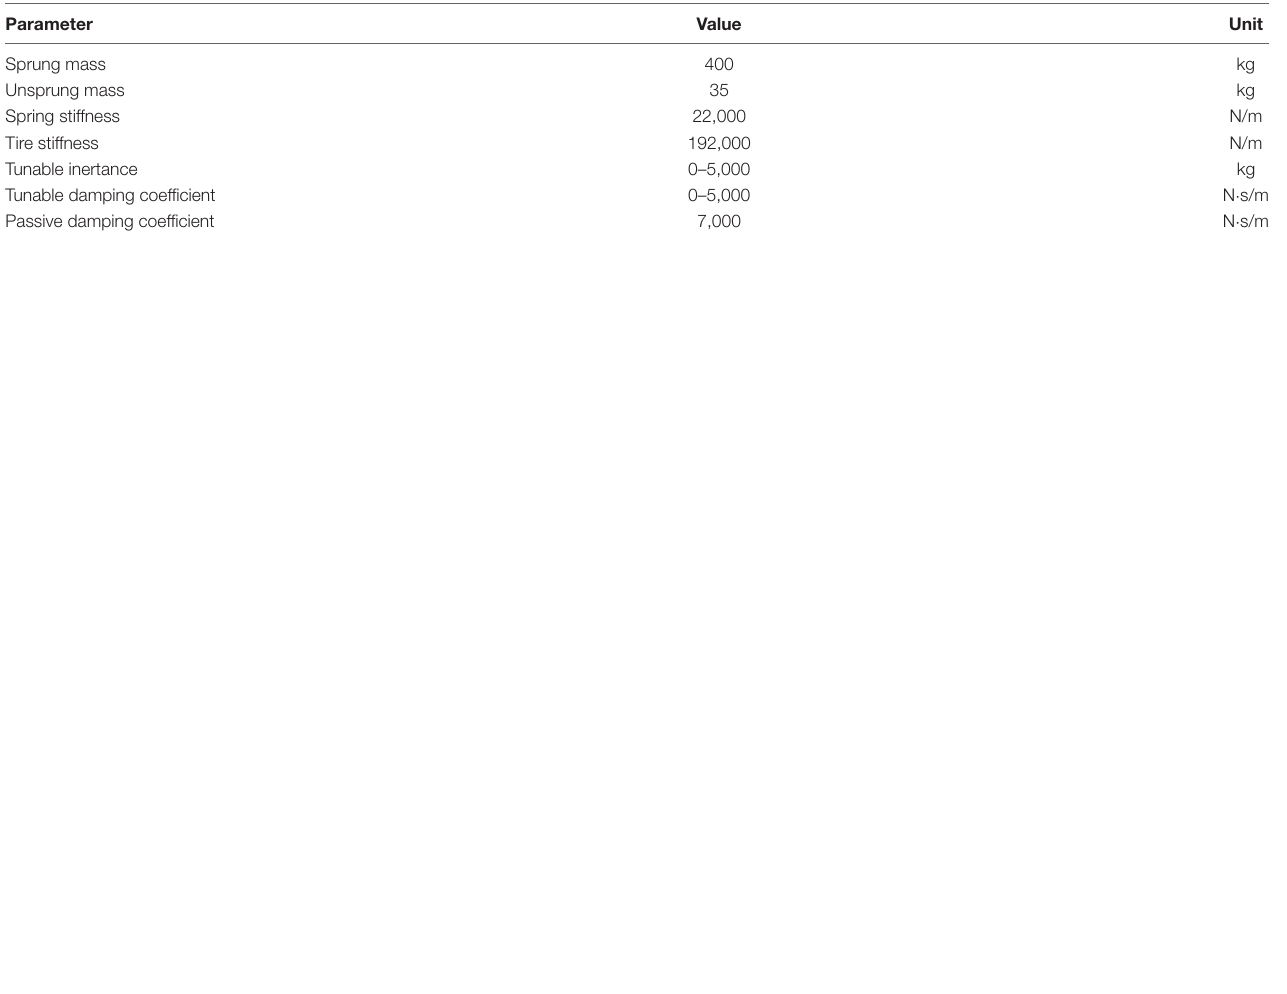
TABLE A2 | Simulation parameters of 1/4 vehicle